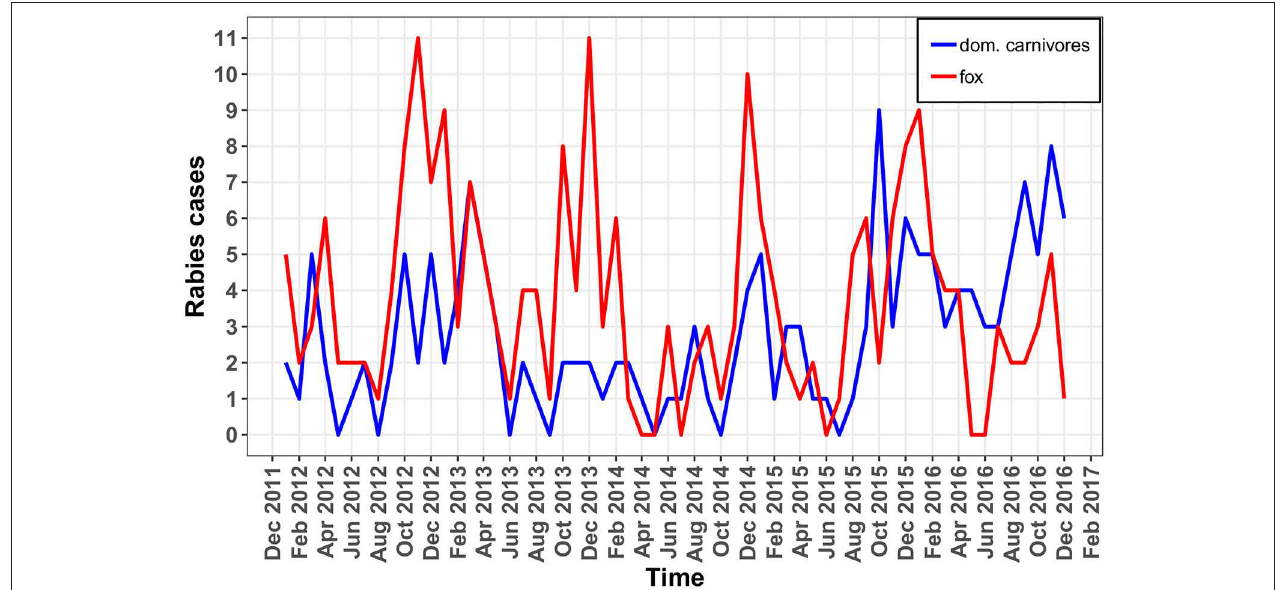
FIGURE 2 | Epidemic curves of rabies in foxes (red line) and domestic carnivores (blue line) in monthly period.